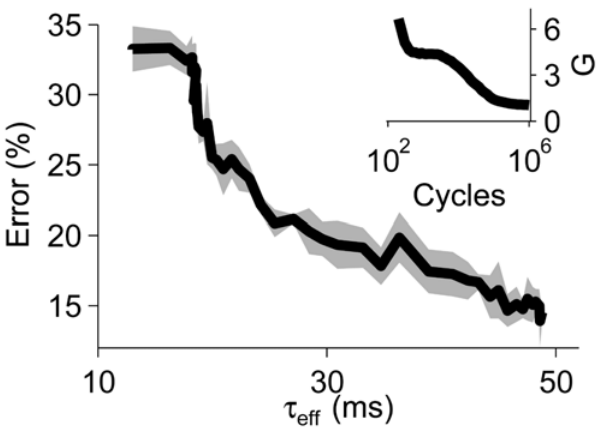
Figure 5. Task dependence of the learned total synaptic conductance. Error frequency of the conductance-based tempotron versus its effective integration time t eff . After switching from time-warp to Gaussian spike jitter, t eff increased as the mean time-averaged total